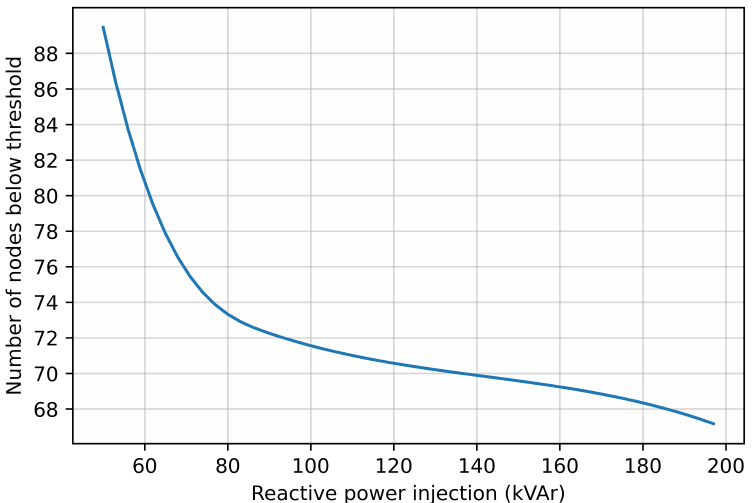
Figure 13. Number of nodes with minimum RMS node voltage below threshold for different levels of reactive power